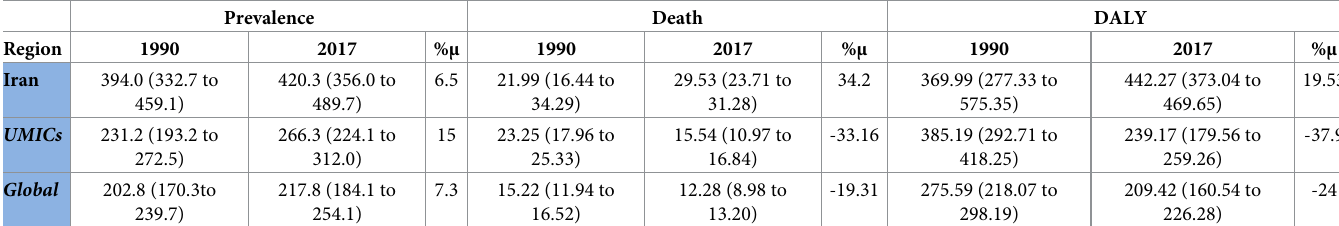
Table 5. Prevalence, death and DALY rate per 100,000 (age-standardized) for both sexes.